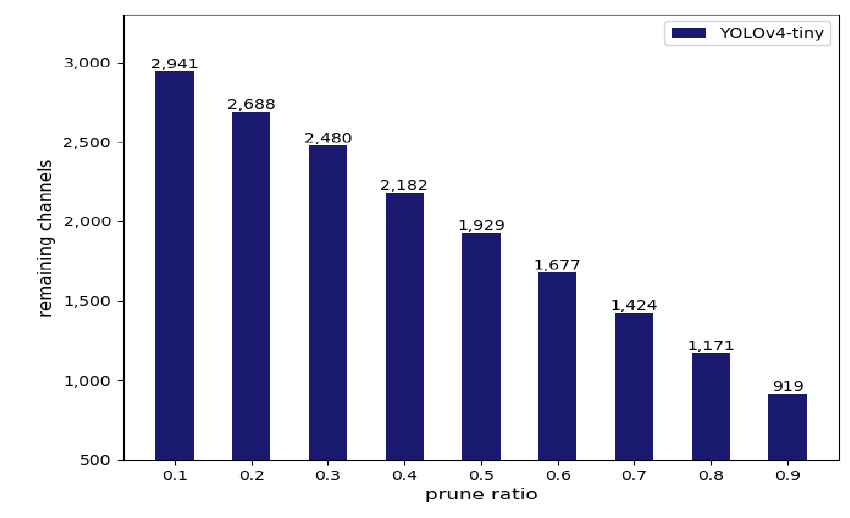
Figure 12. Number of channels remaining in the model with different pruning